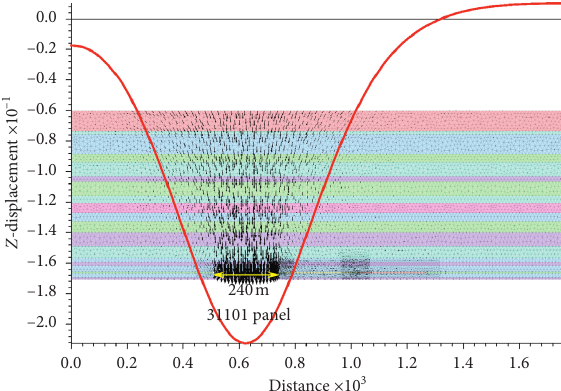
Figure 17: Subsidence of 31101 panel.